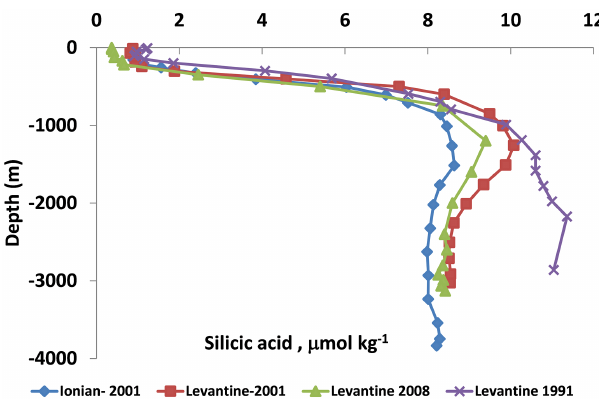
Figure 1. Typical silicic acid profiles in the Levantine basin prior to the effect of the EMT event (1991) and after the EMT event (2001 and 2008). A profile in the Ionian (2001) is included for comparison. Data from Kress et al. (2003,